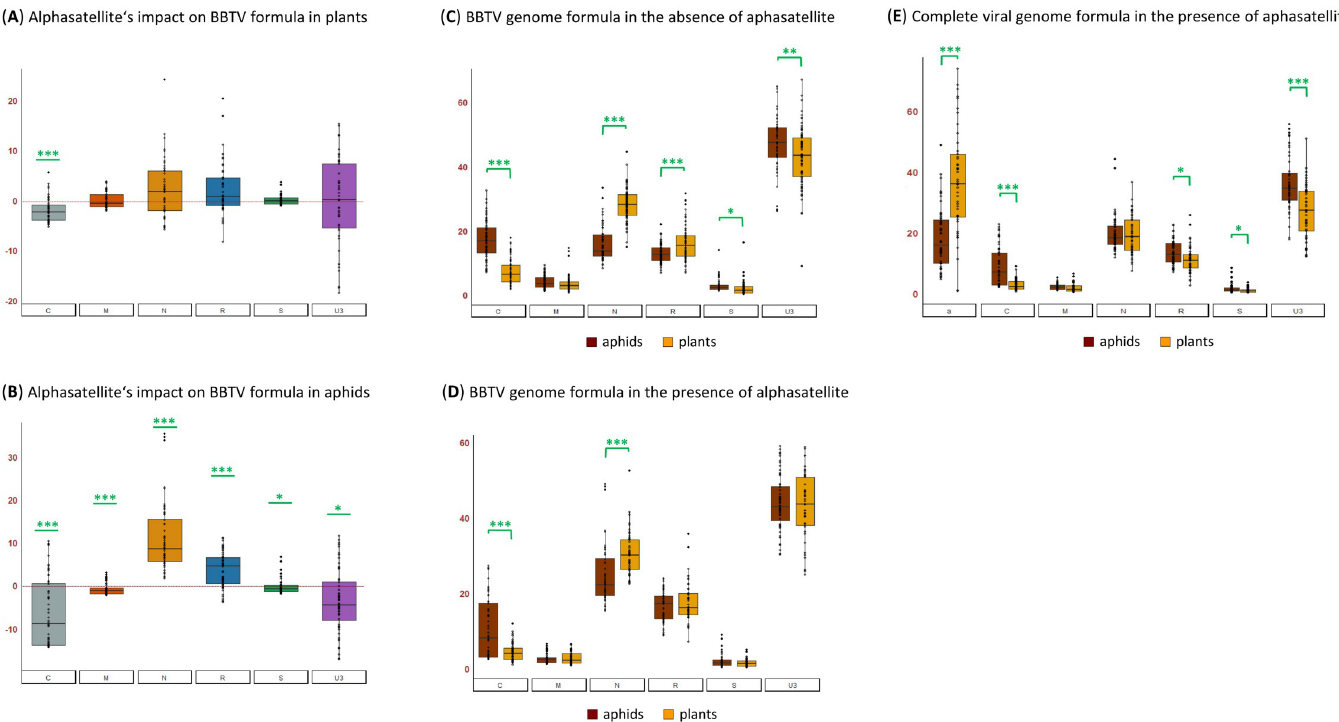
Fig 5. Impact of DRC alphasatellite on BBTV genome formulas in banana plants and aphids. Relative abundance (formula) of BBTV genome components in the presence and absence of alphasatellite was calculated in infected plants and aphids from all transmission experiments (see Fig 4D and 4E). ( A-B ) Alphasatellite-mediated alterations in BBTV genome formula in plants ( A ) and aphids ( B ) plotted for each component as difference in its percentage (above zero when increased and below zero when decreased). ( C-D ) Comparisons between BBTV genome formulas in plants and aphids in the absence ( C ) and presence ( D ) of alphasatellite plotted in percentage of total BBTV DNA. ( E ) Comparison between virome (BBTV + alphasatellite) formulas in the plants and aphids containing alphasatellite plotted in percentage of total viral DNA. � Kruskal-Wallis P < 0.05. ��� Kruskal-Wallis P < 0.005.